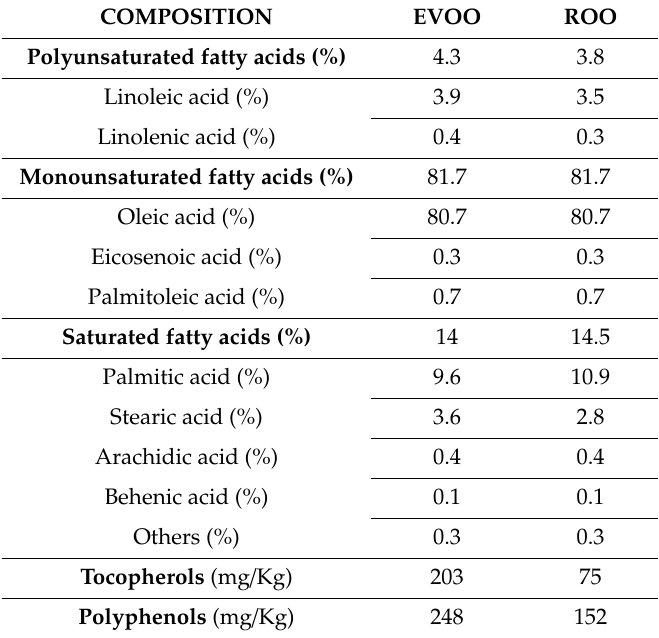
Table 1. Chemical characterization of the olive oils used in the study (EVOO: extra virgin olive oil; ROO: refined olive